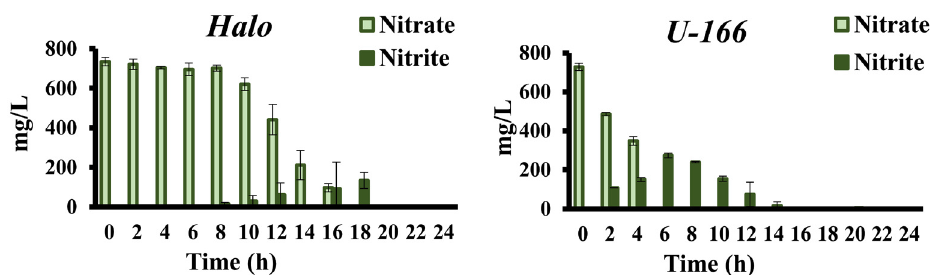
Figure 2. Ion chromatographic studies of the DN microbial consortium isolated from Halo and U-166 shipwreck sites. Samples were collected every 2 h for a period of 24 h and nitrate and nitrite levels were determined. Note: Nitrate values were above the calibration level (100 mg/L) and are thus estimates (but proportional).